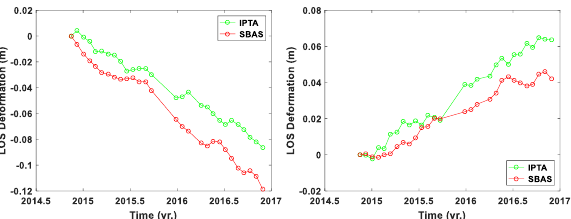
Figure 10. Deformation time series corresponding to points 1 and 2 obtained from both IPTA and SBAS.